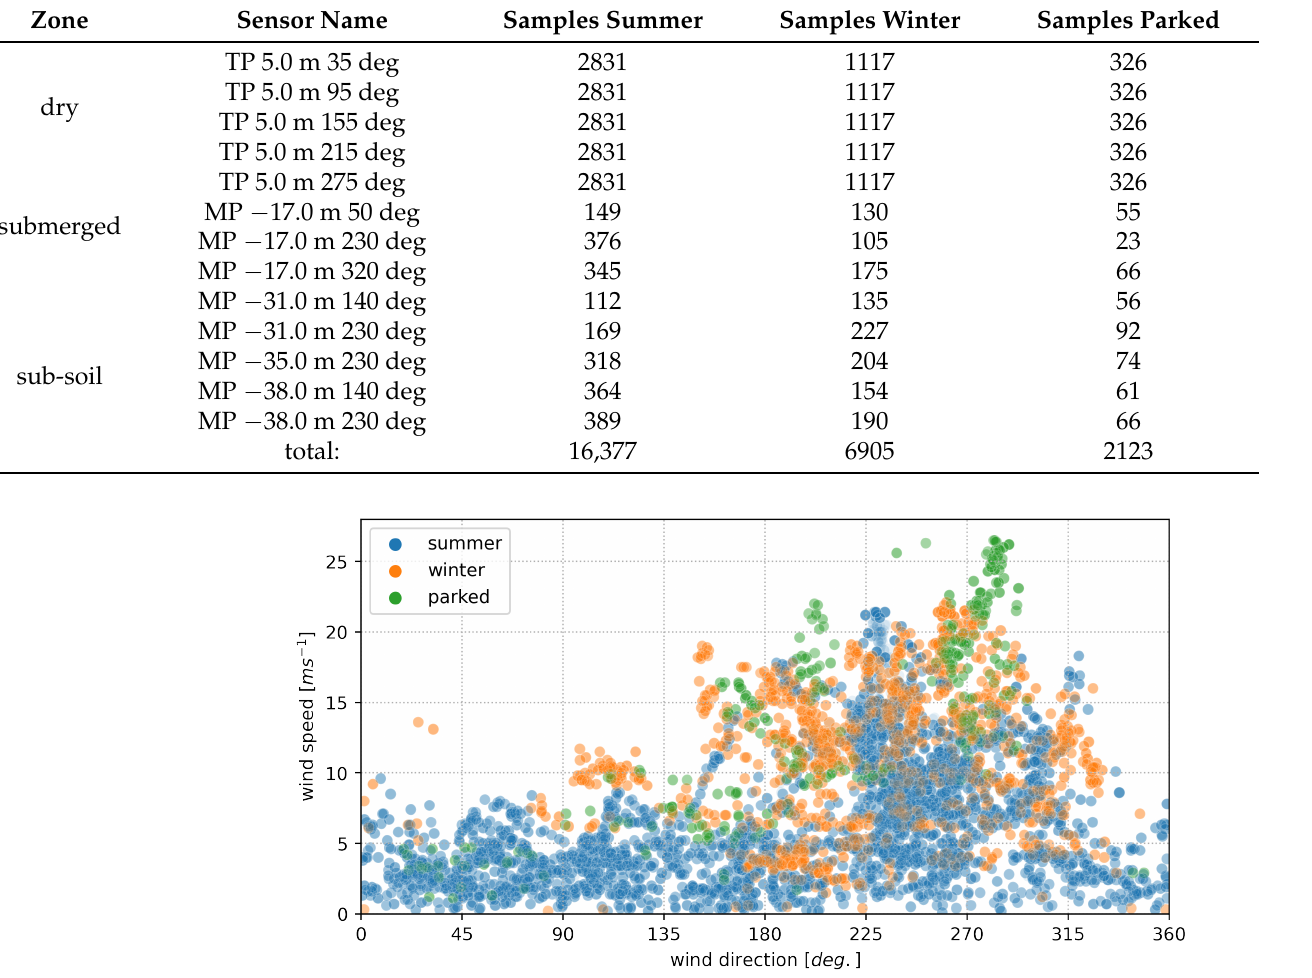
Figure 10. Wind distribution for estimated